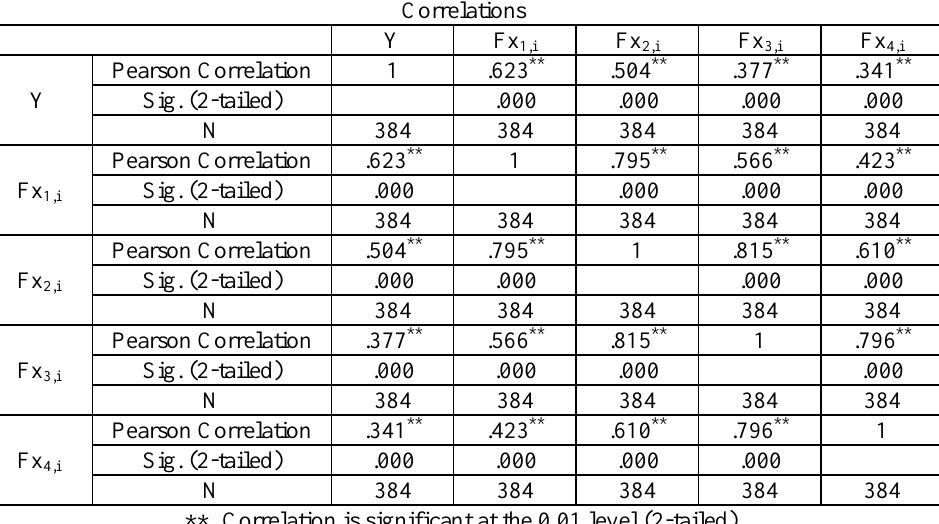
Table. 9. Results of Correlation Coefficient of Model in Sample Related to Research Hypotheses